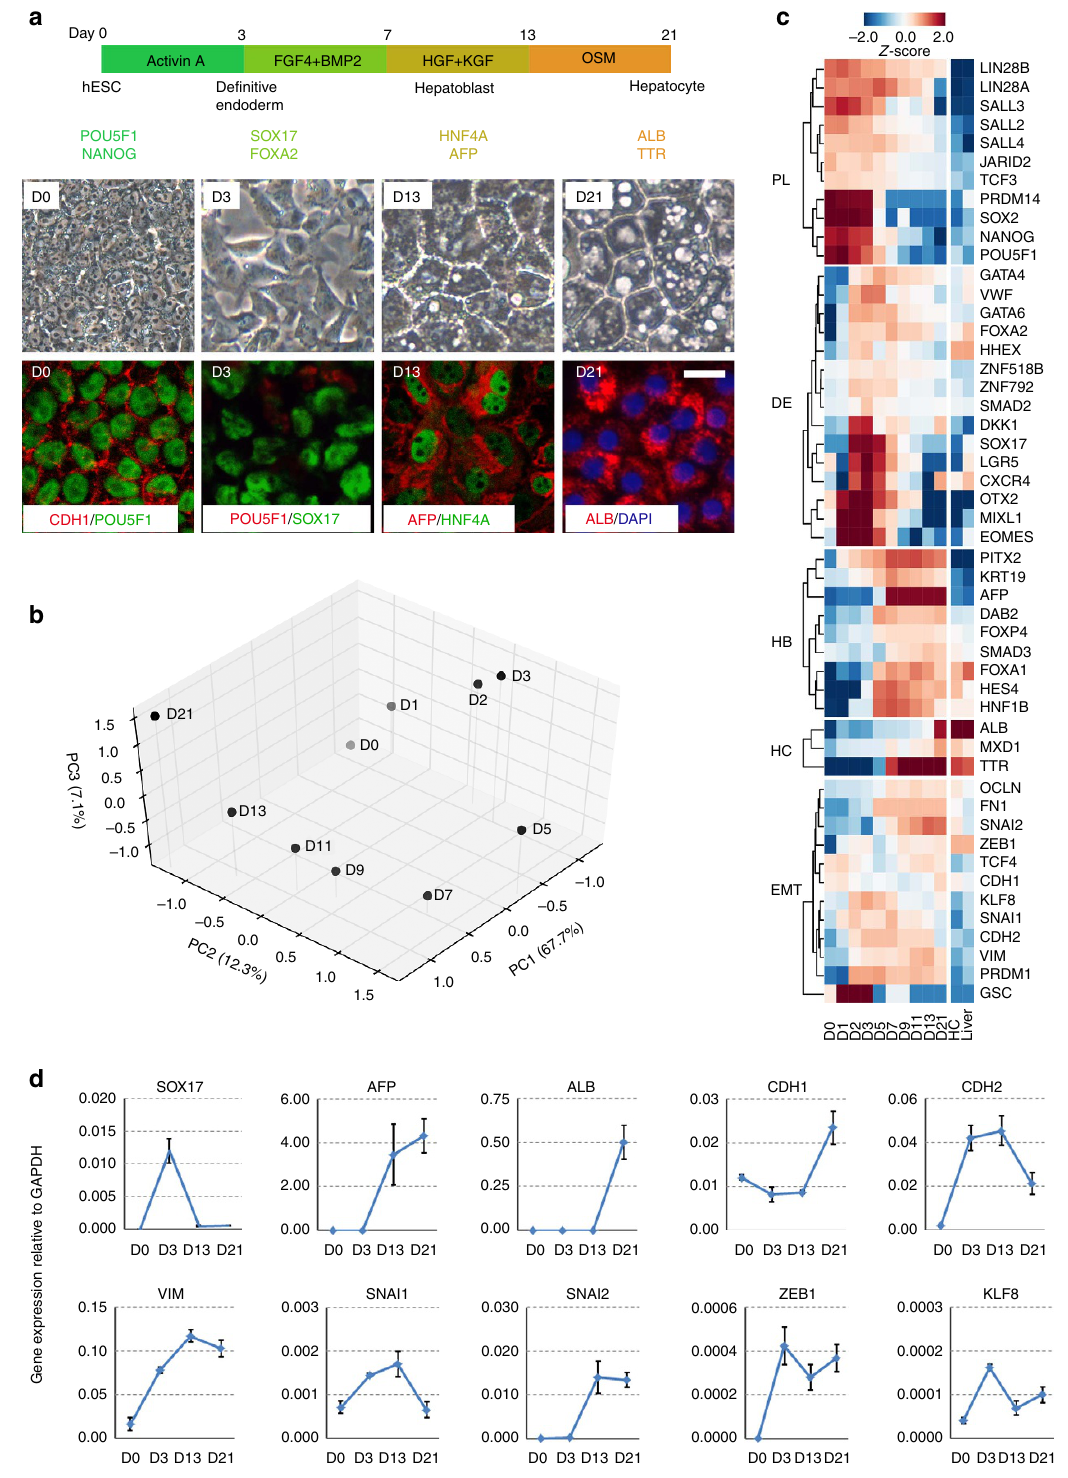
Figure 1 | Gene expression analysis of the hepatic differentiation of hESCs. ( a ) Schematic of the protocol and stages of the hepatic differentiation of hESCs. Representative live photos as well as images of immunofluorescence staining of marker molecules at the indicated stages were shown. Scale bar, 20 m m. ( b ) Principal component (PC) analysis indicates the transitions that occur during differentiation. Gene loadings for PC1-3 were listed in Supplementary Fig. 2. ( c ) Expression of selected marker genes from the RNA-seq data. RNA-seq data of primary human hepatocytes (HC) and liver were listed as positive control. From top to bottom, the marker genes are: pluripotency (PL), definitive endoderm (DE), hepatoblast (HB), hepatocyte (HC) and EMT-related genes. RNA-seq data from primary human hepatocytes were taken from GSE43984, GSE57312 and liver SRR002322, GSE13652. ( d ) qRT-qPCR analysis of listed genes at the indicated stages of hepatic differentiation of hESCs (normalized to GAPDH). Data represent mean ± s.d. from three biological